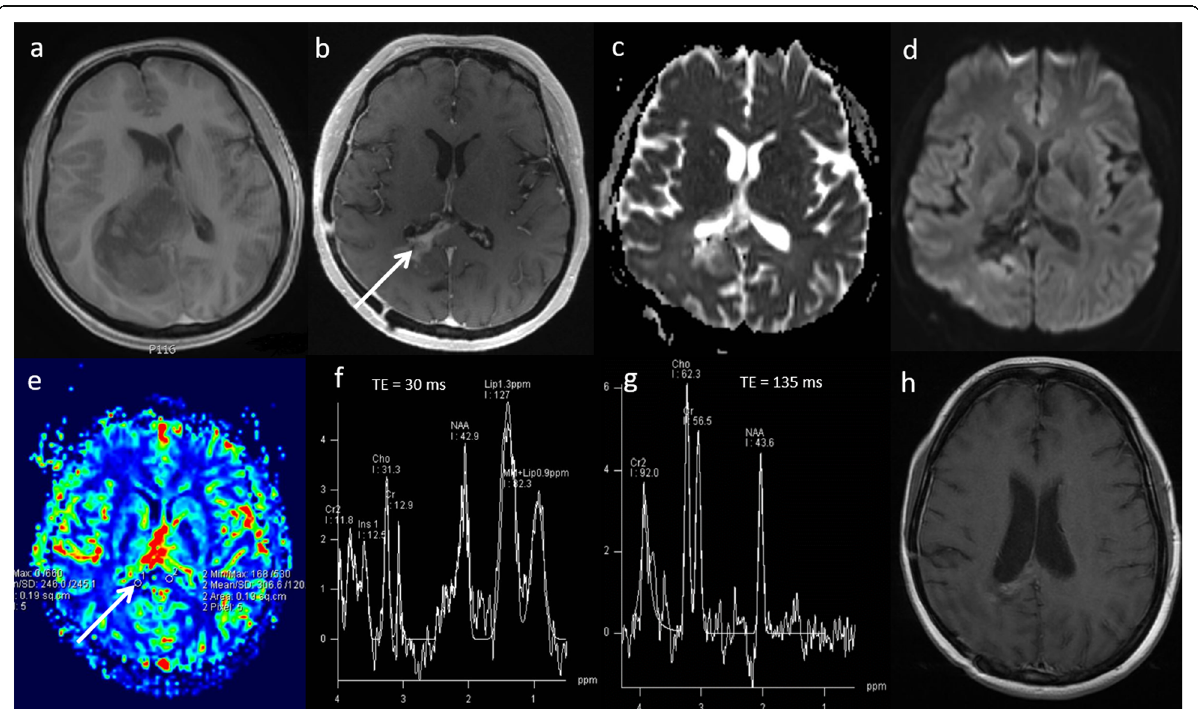
Fig. 8 Glioblastoma — pseudoprogression. a Pre-operative T1-weighted image shows a right deep parietal region glioblastoma. b Conventional post-contrast T1-weighted image approximately 4 weeks after chemoradiotherapy treatment demonstrates a significant increase in the contrast- enhancing area (arrow). Multiparametric MRI at this timepoint demonstrates: c , d areas of high ADC (1186 × 10 − 6 mm 2 s − 1 ), ( e ) a low rCBV ratio (1.4, arrow) on PWI, ( f , g ) a low Cho/Cr ratio (1.4), a low Cho/NAA ratio and presence of lipid and lactate on MRS. Combination of parameters suggest pseudoprogression. h Clinical follow-up and conventional post-contrast T1W sequence at six months confirms a decrease in the amount of enhancing disease, indicating